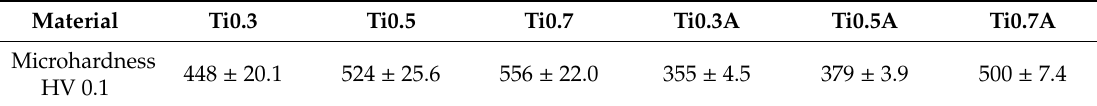
Table 5. Results of microhardness testing on the sintered and annealed bulk materials.